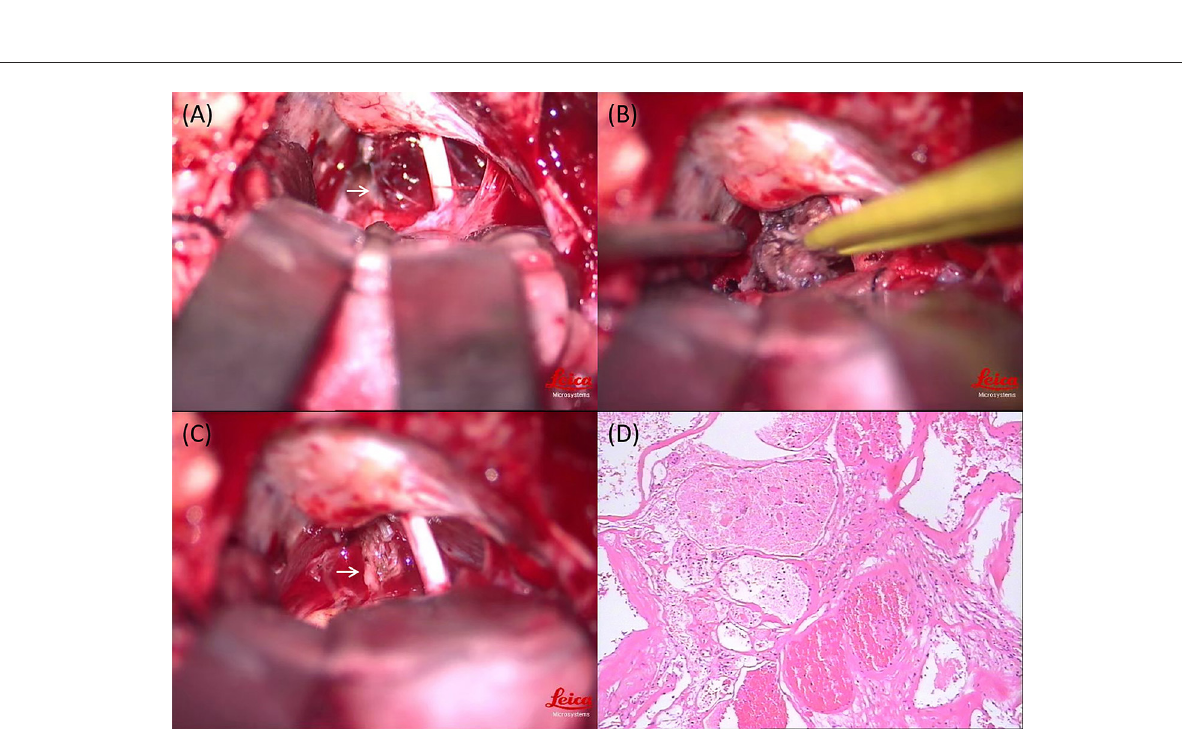
FIGURE2 Intraoperative photography and histopathological examination of the lesion. (A) Intraoperative view: the lesion was dark-red, had an abundant blood supply, and contained vessel-like structures (white arrow). (B) Intraoperative view: the lesion was resected en bloc. (C) Intraoperative view: the right trigeminal nerve motor root was carefully preserved (white arrow). (D) Histopathological examination of the lesion (magnification ×